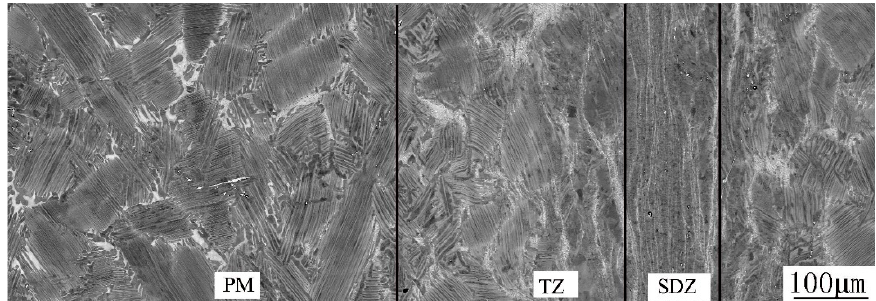
Figure 6. Microstructure evolution from PM to SDZ along axial direction of the CJ.